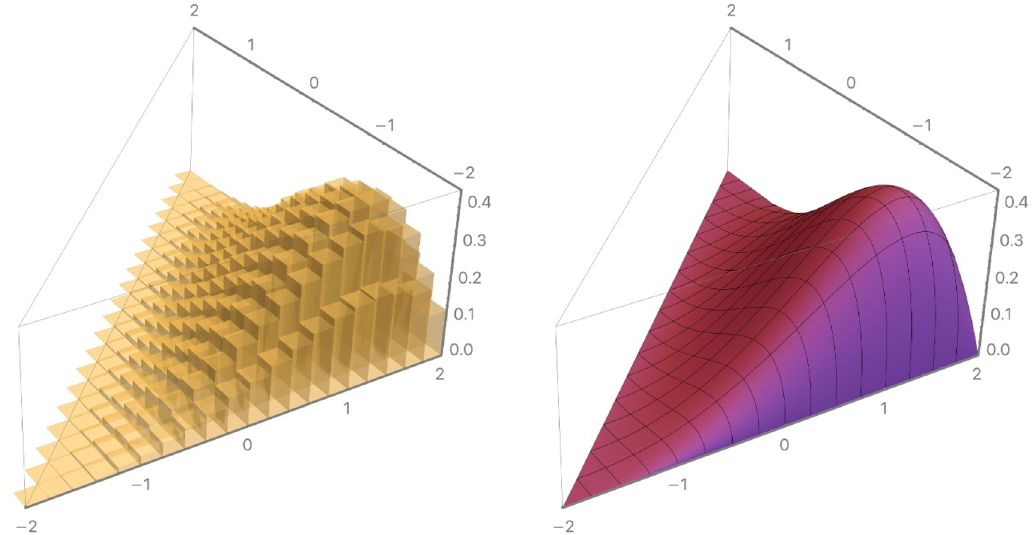
Figure 22 . On the left: a histogram of the frequency of (~ (cid:11); ~ (cid:12) )-points using data for the 500 primes, p 3 (cid:20) p (cid:20) p 502 . On the right: a plot of the function p 2 h from (B.5). p (cid:0) 1 and p . The expected number of factorisations, for given p , is then p times